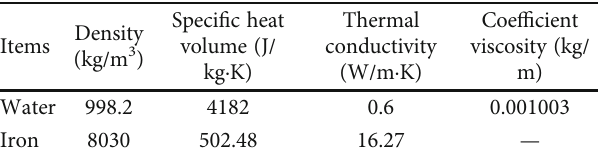
Table 2: Material